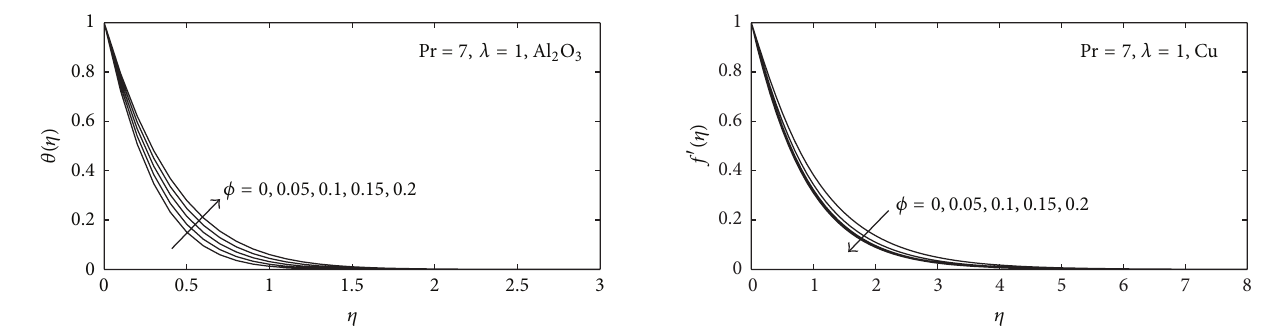
Figure3:Velocityprofiles 𝑓 󸀠 (𝜂) fordifferentvaluesof 𝜙 whenPr = 7 and 𝜆 = 1 using Cu nanoparticle.